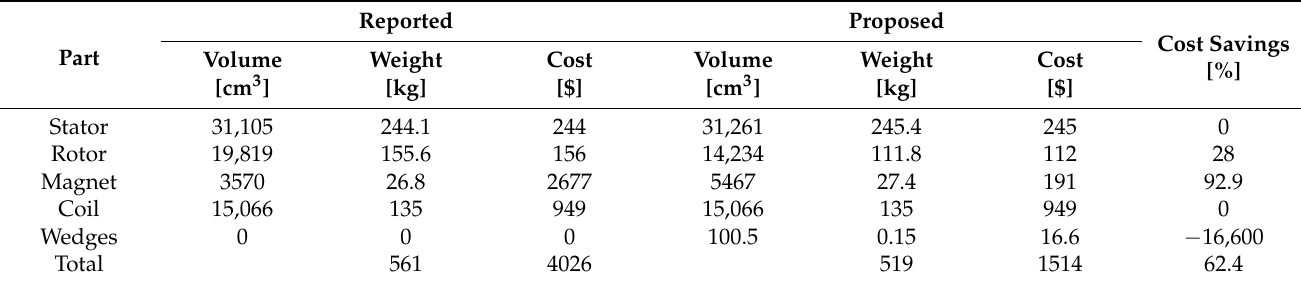
Table 13. Volume, weight, and cost of the reported and proposed